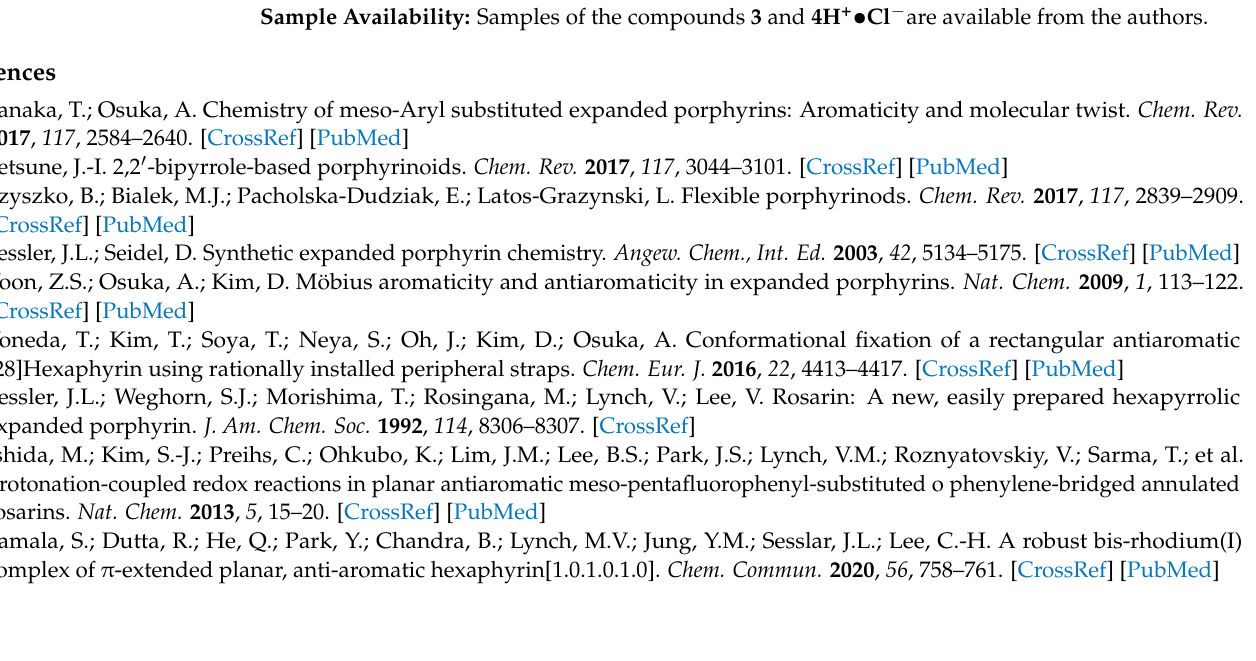
Figure S16: 13 C-NMR of 4H + • Cl − , Figure S17: UV-vis absorption spectra of 4H + • Cl −